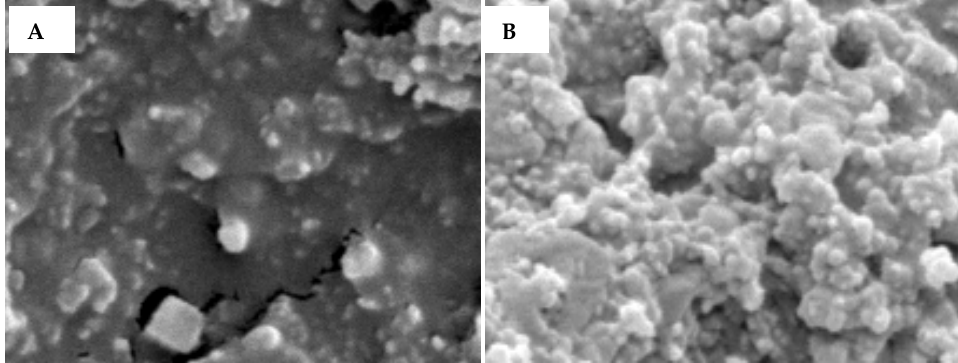
Figure 3. FESEM surface images of ( A ) a bare carbon electrode and ( B ) a carbon electrode modified with an anti-human IgM antibody using the streptavidin/biotin immobilisation system.